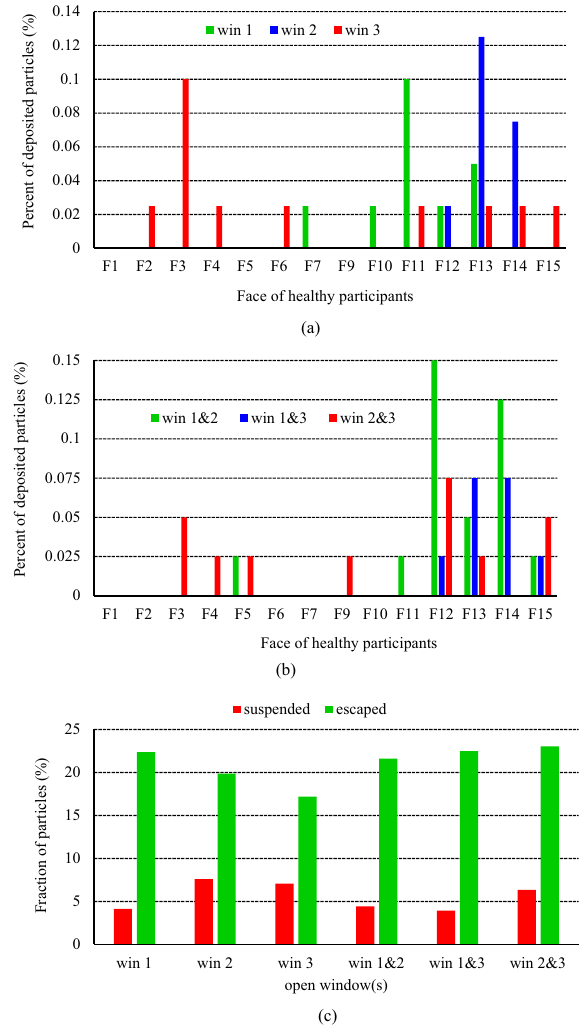
Figure 16. Effects of the exhaust layouts on the exposure risk of healthy participants during scenarios 5 through 10; ( a ) and ( b ) the fraction of the particles deposited on the healthy individuals’ faces, respectively in scenarios 5, 6, 7, and 8, 9, 10, and ( c ) the fraction of the suspended and escaped particles at the end of particle